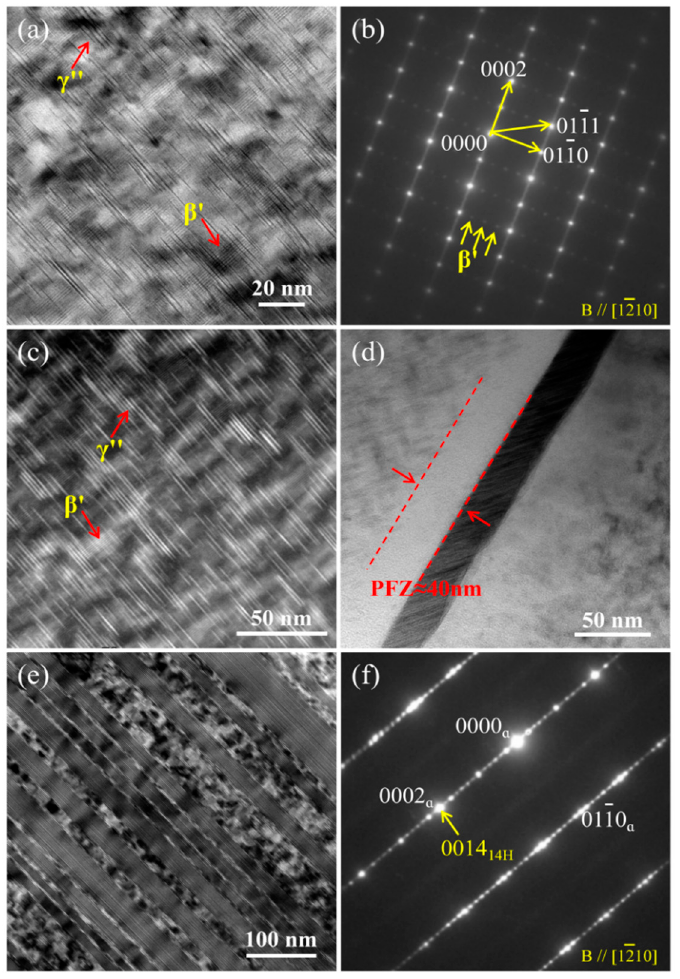
Figure 7. Microstructure of the T6 alloy: ( a , b ) and ( e , f ) TEM images and corresponding SEAD patterns; ( c ) high-angle annular dark field (HAADF)-STEM image; ( d ) bright-filed TEM image. Notes that yellow arrows represent superstructured la tt ice.